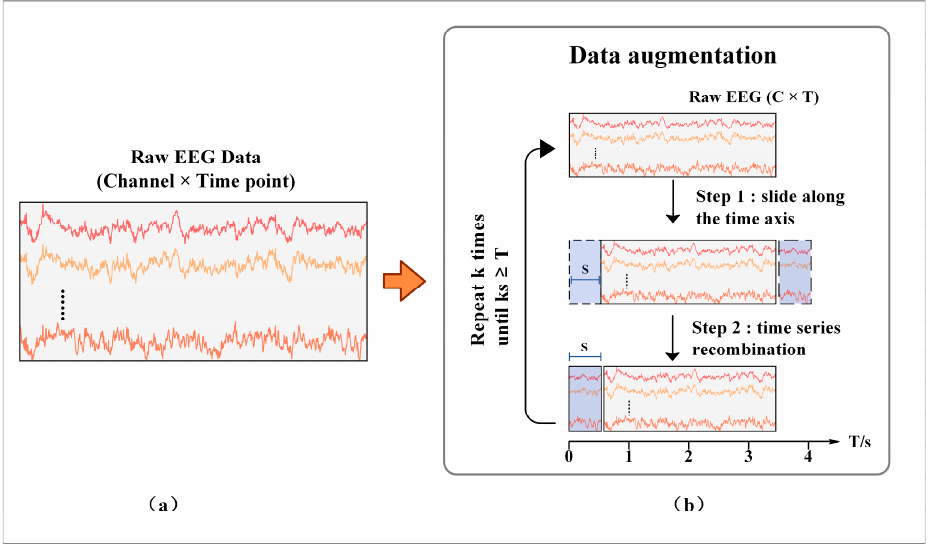
Figure 2. The proposed data augmentation method. ( a ) Representation form of the raw EEG; ( b ) the process of data augmentation. ( b ) the process of data